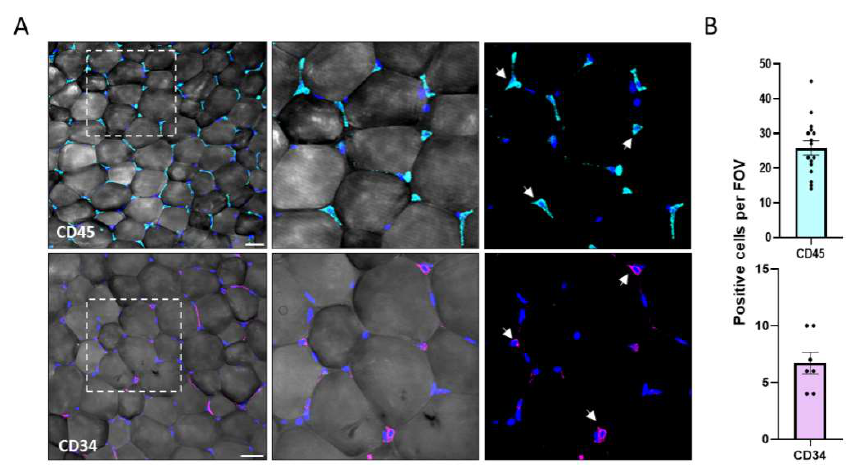
Figure 3. Whole-mount 3D staining of non-adipocyte subpopulations. ( A ) Immunofluorescence staining of CD45+ (cyan), CD34 +(magenta), and cell nuclei (DAPI, blue) in whole mount adipose tissue. (Magnification of × 200, scale bar = 50 µ m). ( B ) Quantification of CD45+ (cyan) and CD34 + (magenta) per FOV.